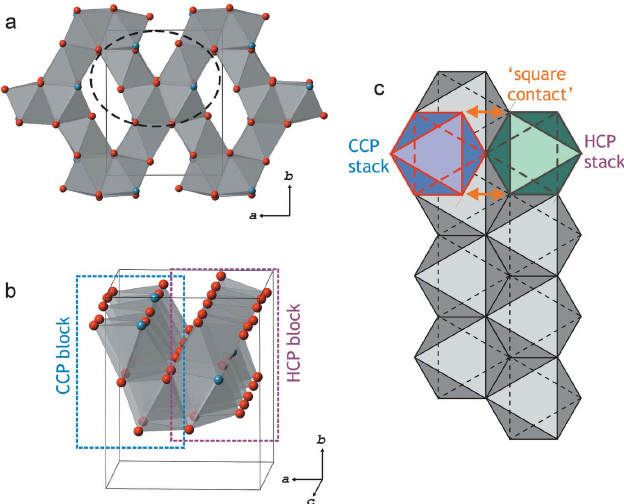
Figure 5 Representation of the crystal structure of danburite-II on the basis of the close-packing approach. ( a ) The arrangement of octahedral voids in the packing of O (red) and Ca (blue) atoms in danburite-II, featuring chains of edge-sharing octahedral voids parallel to the c axis. The area outlined by the dashed line is magnified in panel ( b ). ( b ) Four chains of edge- sharing octahedral voids making up adjacent c.c.p. and h.c.p. blocks. ( c ) A scheme showing the origin of the ‘square contact’ between the c.c.p.